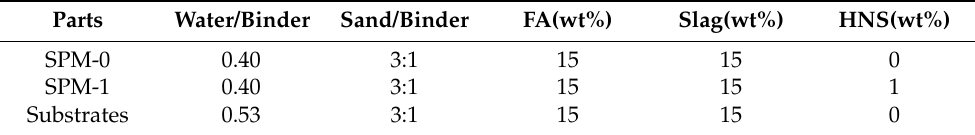
Figure 2. Schematic diagram of the process of applying the protective layer onto the mortar substrate. Table 4. Mix proportions of substrate and different kinds of protective layers.